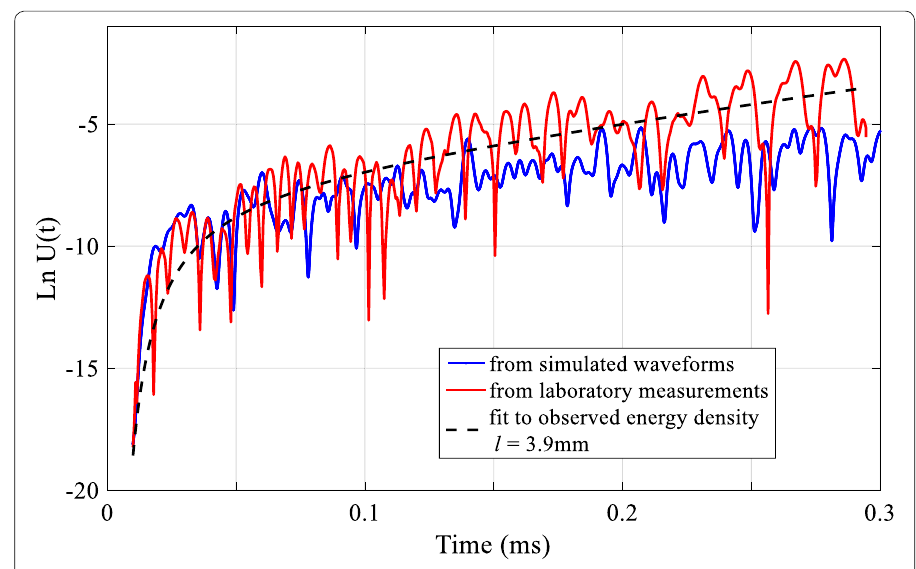
Fig. 4 We characterize the scattering properties using the diffusion model, in both the experimental granite sample used in the laboratory and the medium of the simulation. The logarithmic representation of the energy density Ln U ( t ) used for the linear inversion of the mean free path is represented both in the experimental case (red line) and in the simulated case (blue line). The comparison of both functions shows that the numerical medium reproduces the wave scattering happening in the experimental sample. The dashed black line corresponds to the diffusion model with a mean free path l